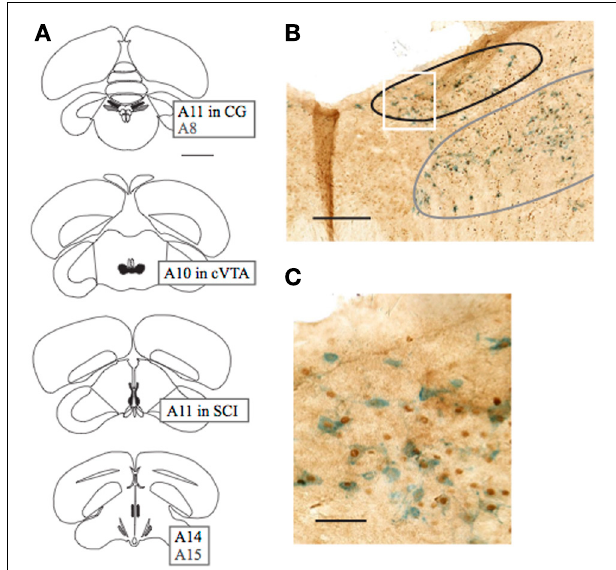
FIGURE 3 | Schematic diagram of dopaminergic areas in which expression of c-Fos was quantified, and example of colocalization. (A) From top (caudal) to bottom (rostral), sections included A11 in CG (black) and A8 (gray), A10 in VTA, A11 in SCI, and A14 (black) and A15 (gray). Expression in A8 was not quantified, but is included for reference to (B) . (B) Image of coronal section containing A11 in CG (black) and A8 (gray) Expression in A8 was not quantified due to difficulty in consistently defining its border. (C) Region outlined in white box in (B) is expanded to illustrate labeling of dopaminergic neurons with tyrosine hydroxylase (blue) and nuclear expression of c-Fos protein (brown). Scale bars in (A–C) indicate 2mm, 250 µ m, and 50 µ m,